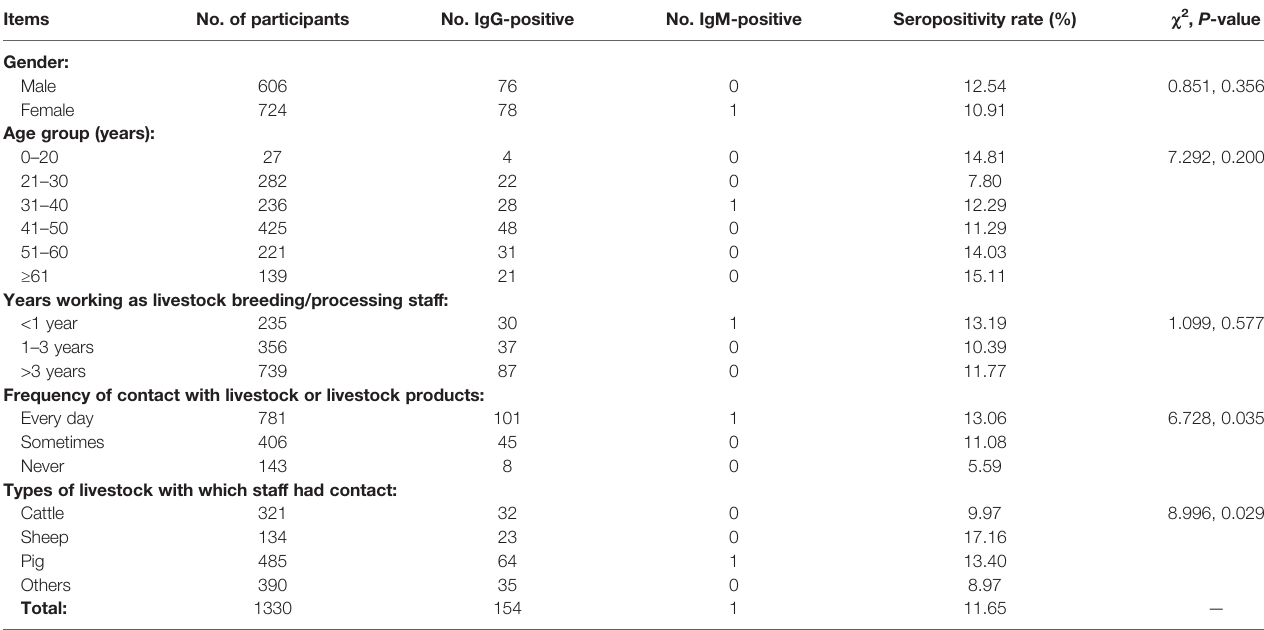
TABLE 2 | Seroprevalence of toxoplasmosis in livestock breeding/processing staff. Items No. of